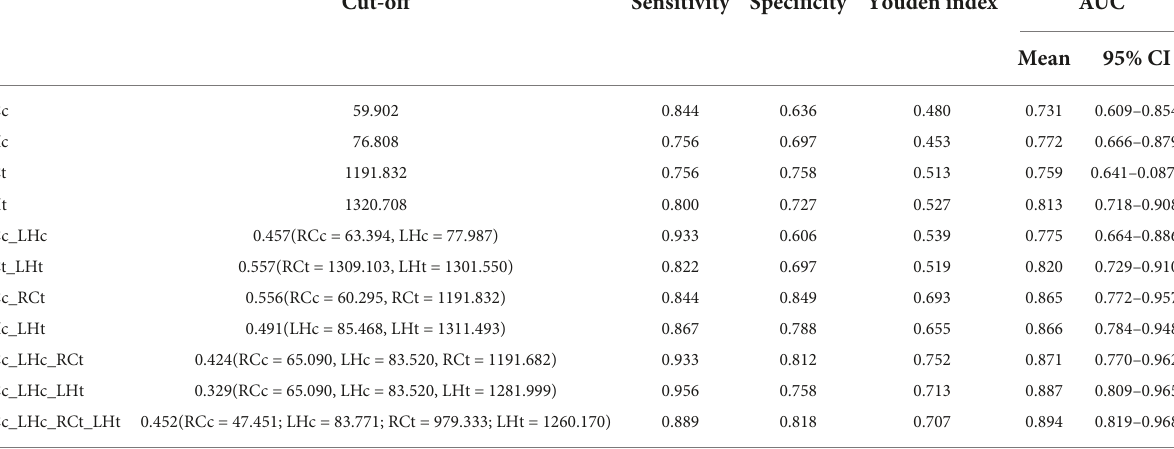
TABLE 2 Receiver operating characteristic (ROC) curves of various parameter